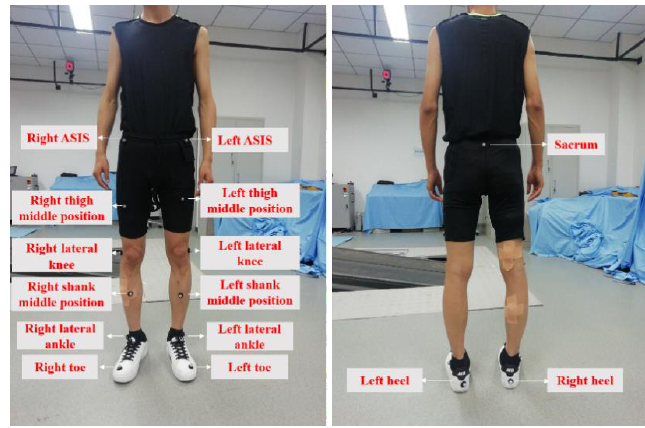
Figure 3. Location diagram of markers.